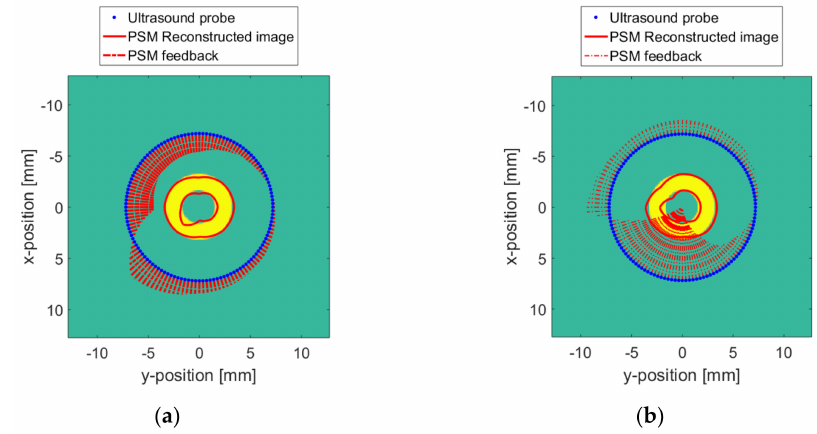
Figure 23. Reconstructed image with the PSM when ∆ v = 128: ( a ) With surface changes; ( b ) With TMC changes.